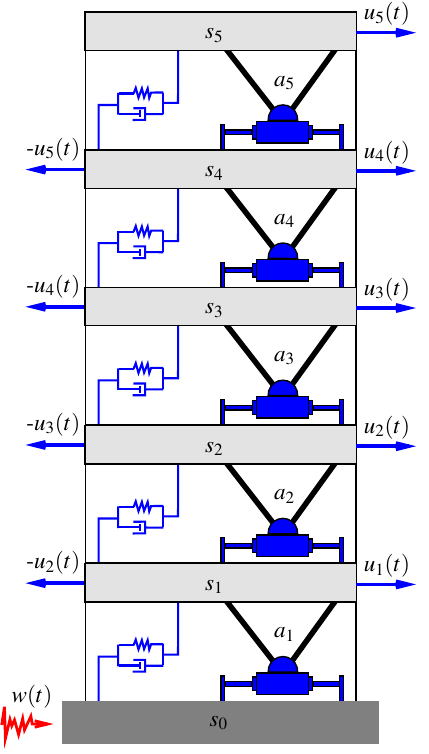
Figure 3: Five-story building mechanical model: actu- ation scheme and external